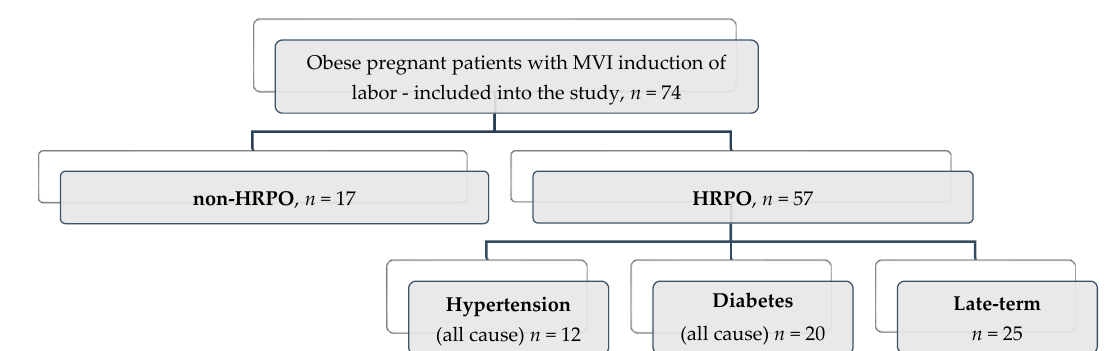
Figure 3. Distribution of the study subjects based on associated criteria in obese pregnant patients with misoprostol vaginal insert (MVI) IOL according to Strengthening The Reporting of Observational Studies in Epidemiology (STROBE) guidelines.